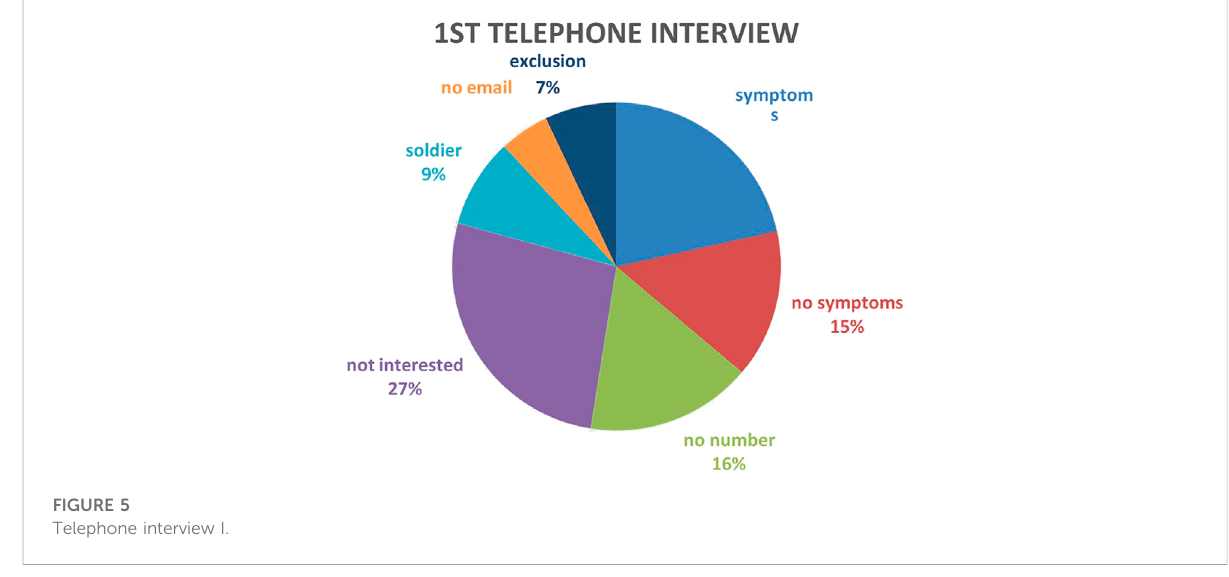
FIGURE 5 Telephone interview I.